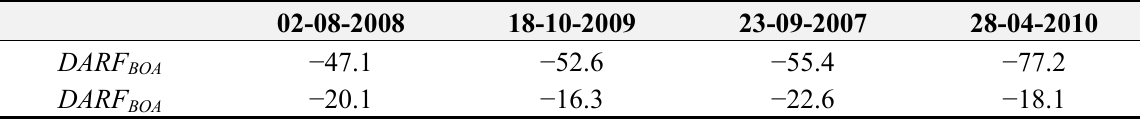
Table 2. Similar to Table 1, except that values of the direct aerosol radiative forcing (DARF) at the top of atmosphere (TOA) and the bottom of atmosphere (BOA) are calculated using Equation